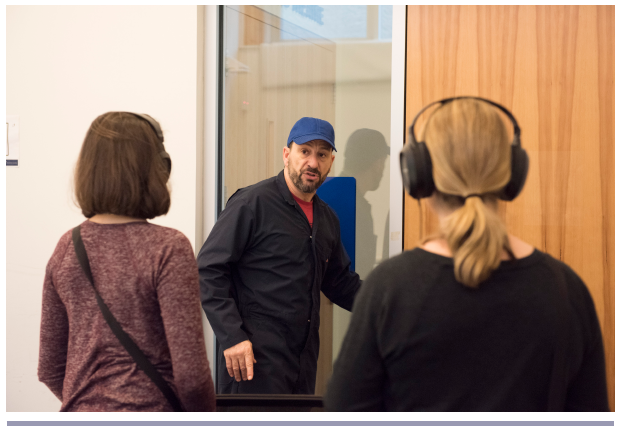
Fig. 1 . The janitor whisks participants into the “secret” room. (Photo by Emily